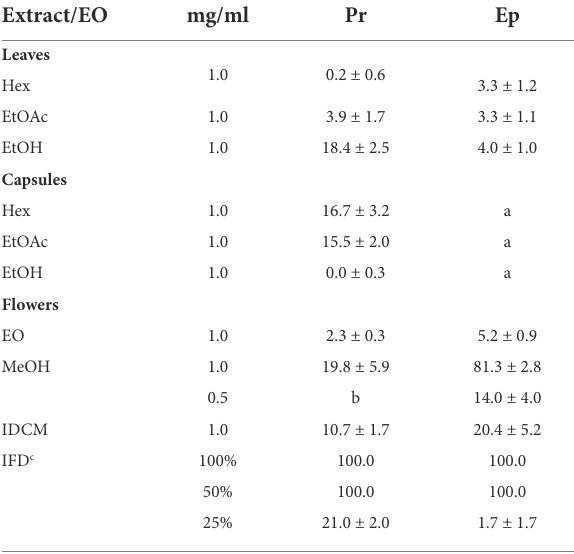
TABLE 3 Activity of extracts and essential oil from P. rhoeas (Pr) and E. plantagineum (Ep) on M. javanica . Results are expressed as percent mortality ± SE.